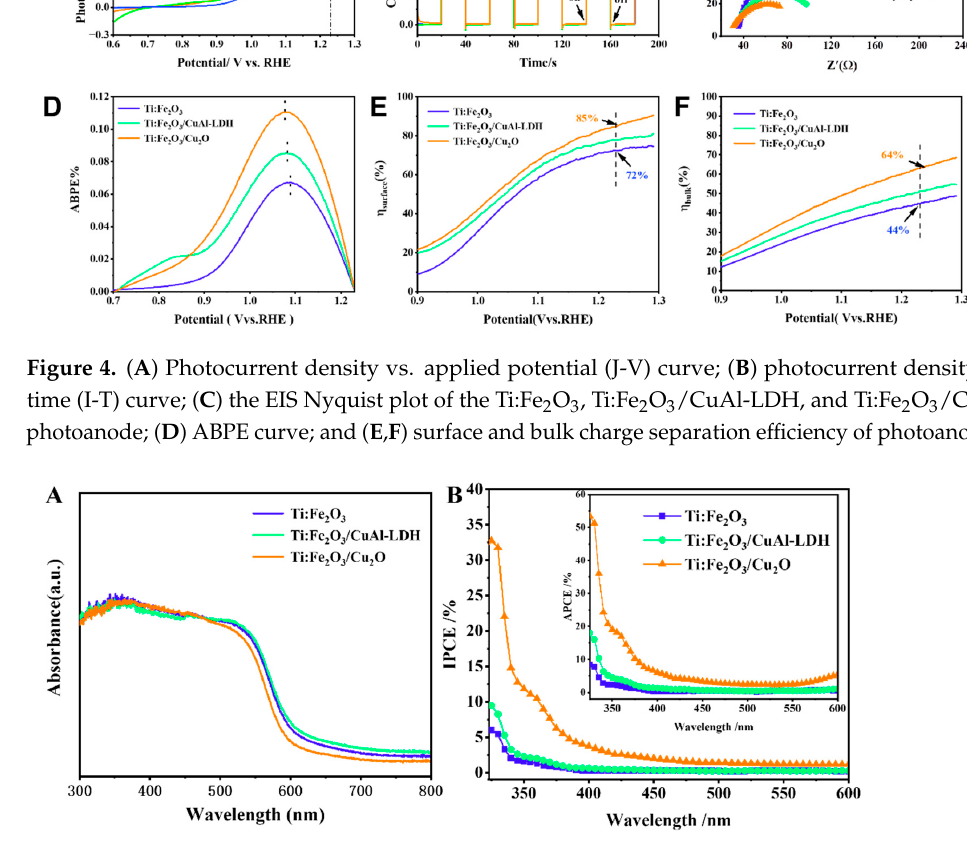
Figure 6. UPS spectrum of ( A ) Ti:Fe 2 O 3 and ( B ) CuAl-LDH/Cu 2 O. Table 2. Fermi level, valence-band maximum (VBM, EVBM), conduction-band minimum (CBM, ECBM), and bandgap energy ( Eg ) (vs. RHE) of Fe 2 O 3 and Cu 2 O.